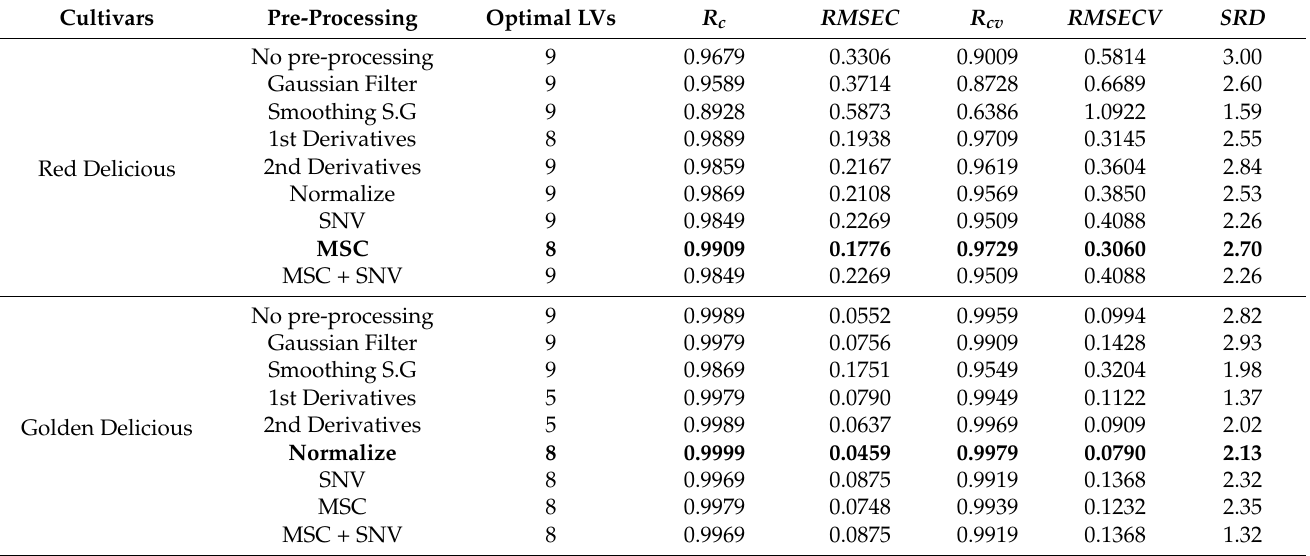
Table 5. Validation results of PLS models based on different hyperspectral imaging pre-processing methods for the SSC of Red Delicious and Golden Delicious